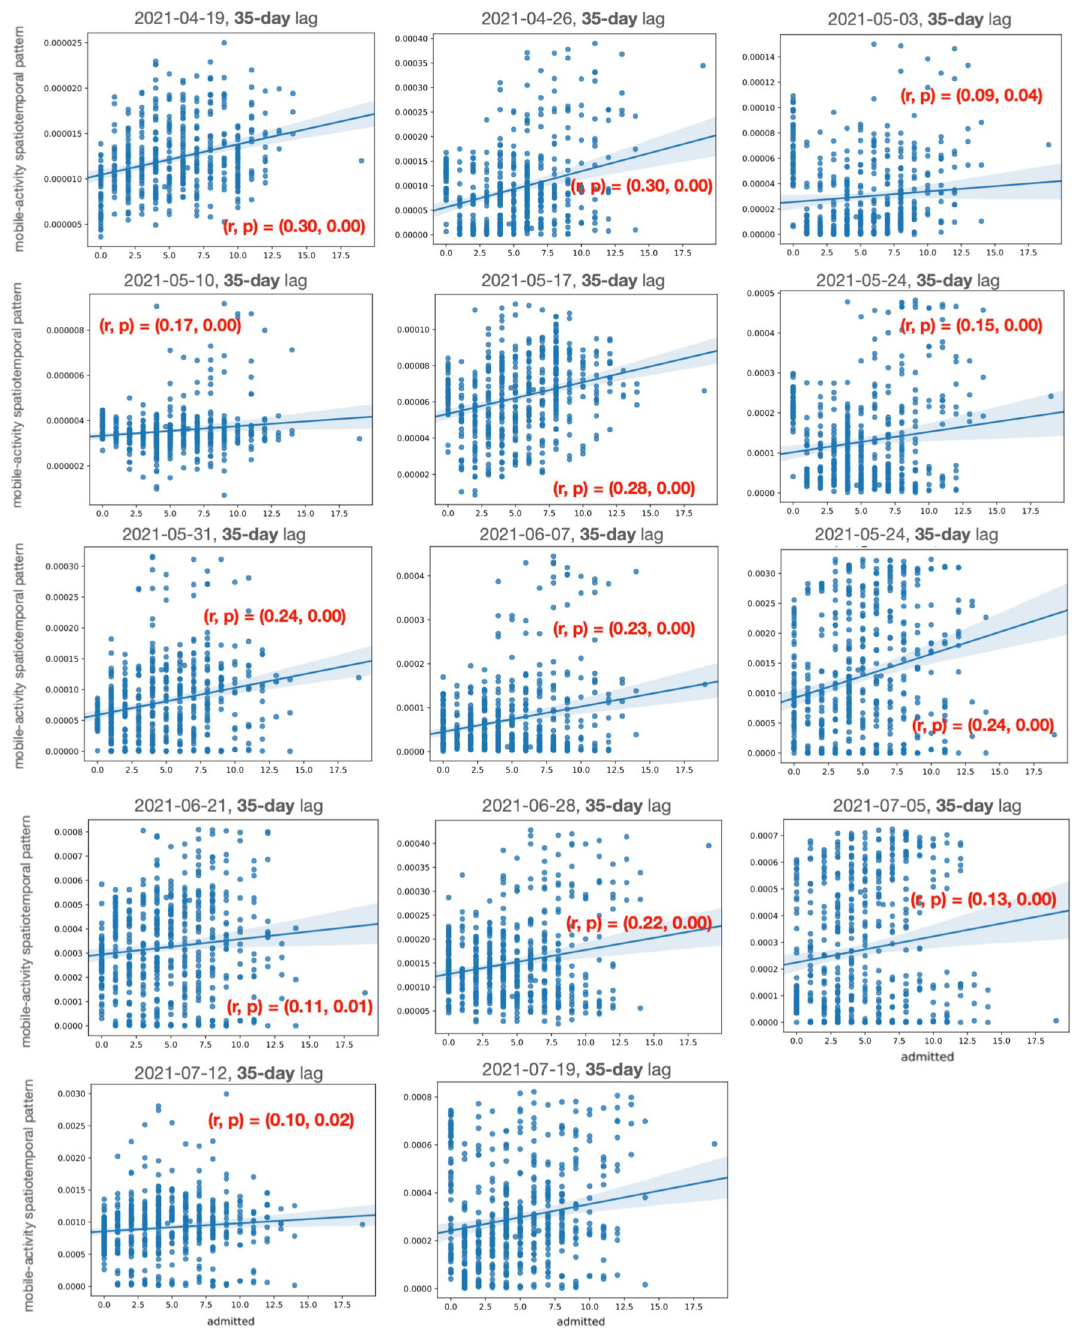
Figure 5. Pearson correlation between the positively correlated spatiotemporal component and the daily number of admitted patients at SÄS. The positively correlated spatiotemporal components are extracted from mobile activity data by the spatiotemporal model. The figures show the correlation (r) score and the statistical significance (p) score across various analysis dates. The figures also show the optimal time lag at which the Pearson correlation between the spatiotemporal components and daily number of admitted COVID-19 patients is at its highest value. The optimal time lag is 35 days for all analysis